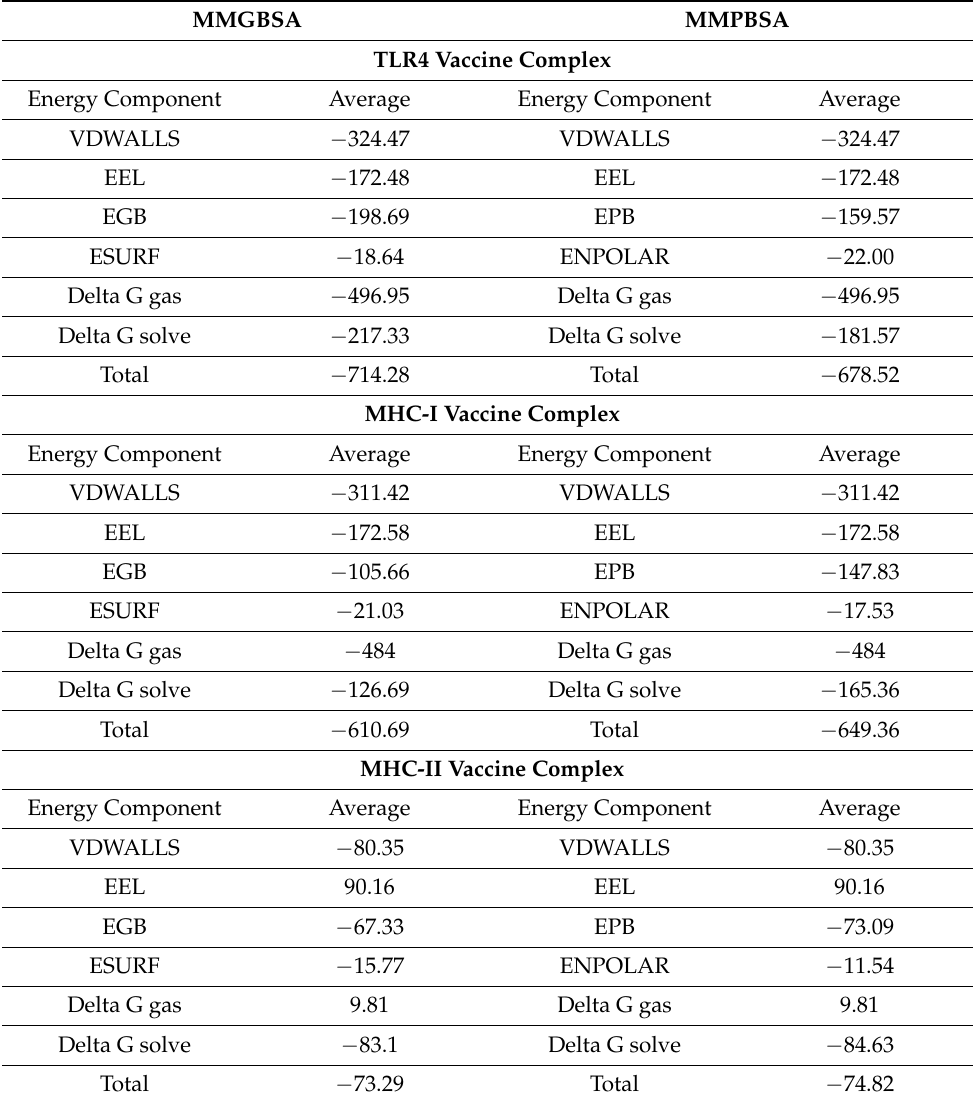
Table 5. MMGB/PBSA binding free energies of receptor(s)–vaccine complex. All values are given in